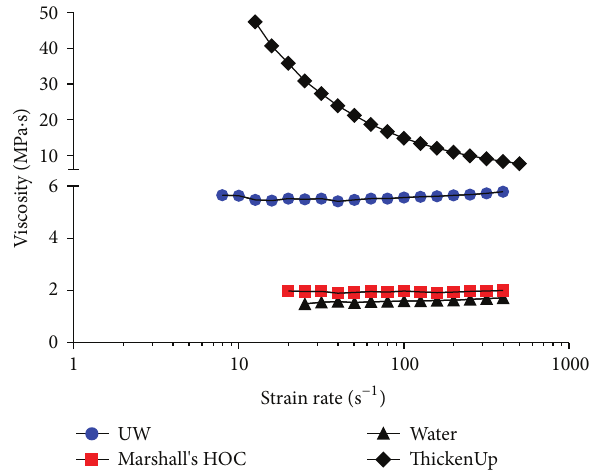
Figure 1: Graph showing the viscosities of UW, Marshall’s HOC solution, water, and ThickenUp Clear over a range of strain rates. Strain rates are plotted on a log scale, and viscosity is plotted on an interrupted axis to enable all values to be shown. Temperature was kept constant at 7 ∘